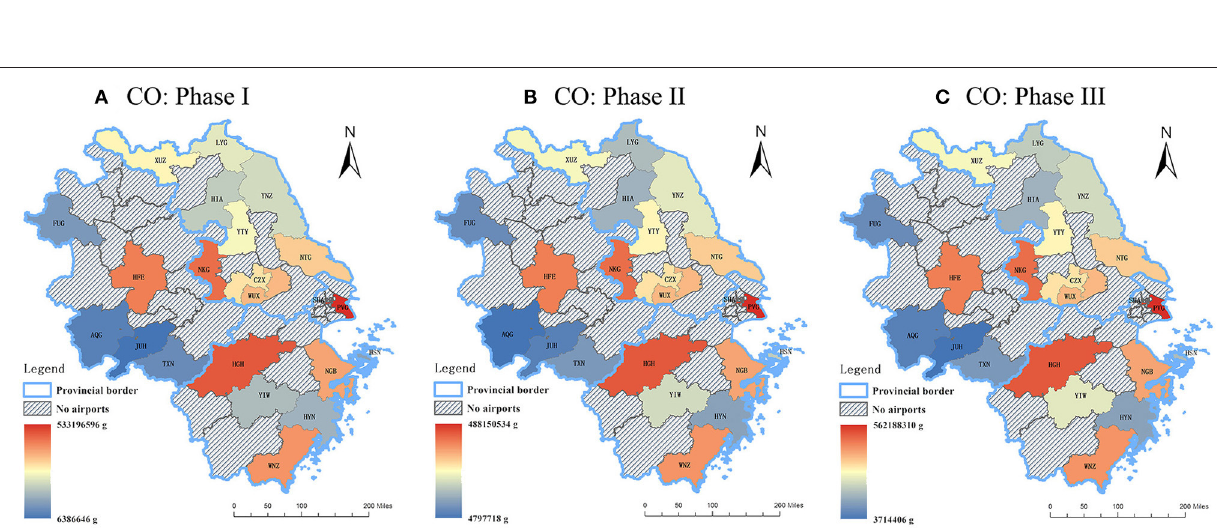
FIGURE 8 | The emission quantity of HC during the three phases of 2020. (A) Phase I : from the beginning of January to the end of April (B) Phase II: from the beginning of May to the end of August (C) Phase III: from the beginning of September to the end of December.